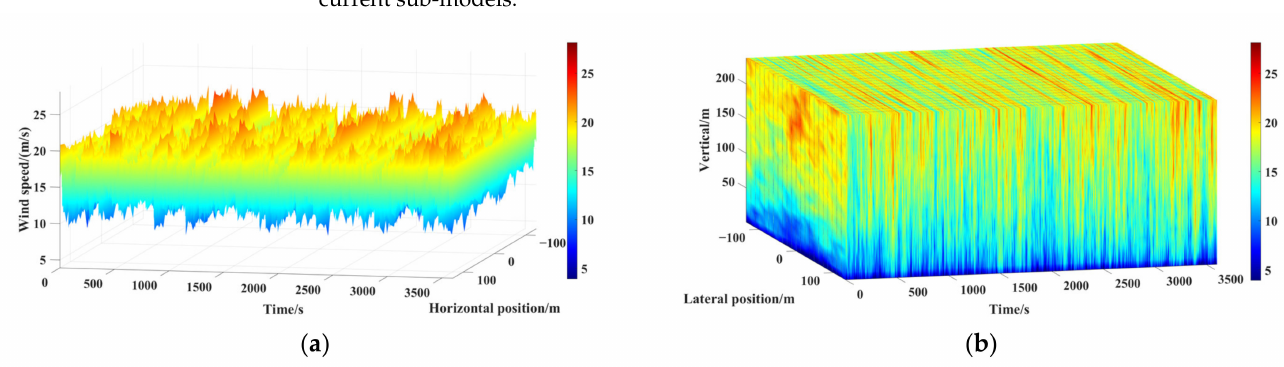
Figure 8. The wave and current information. ( a ) JONSWAP spectrum of waves; ( b ) standard current sub-models.